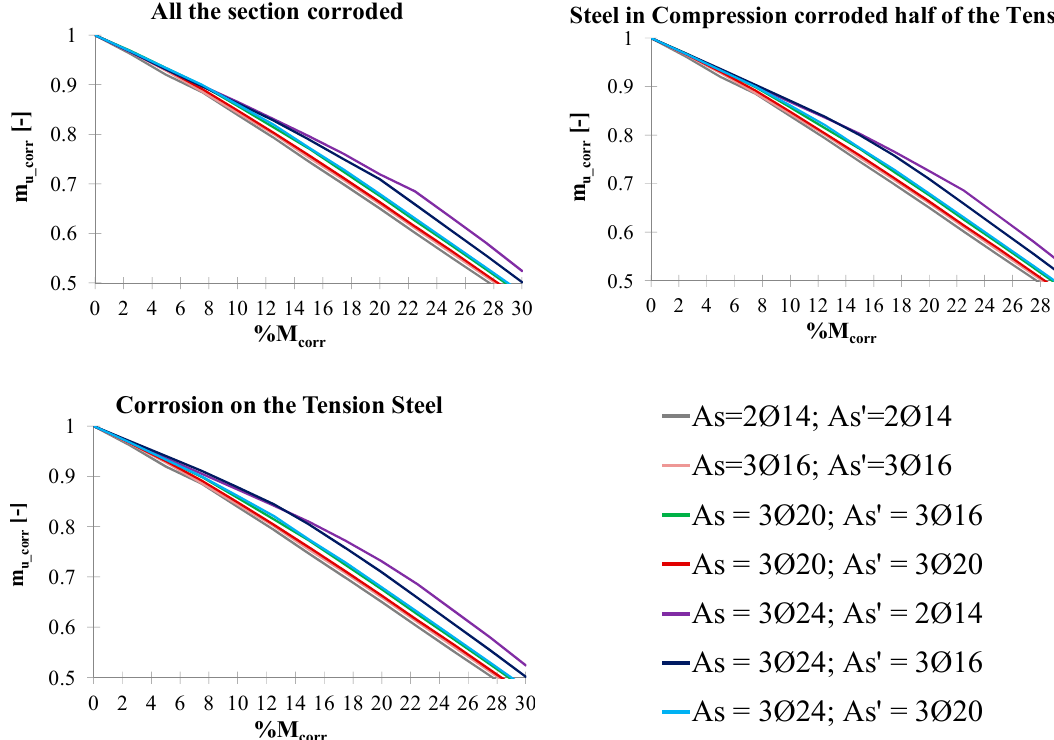
Figure 8. Nondimensional ultimate bending moment for different corrosion scenarios—formed Beam, pitting corrosion.